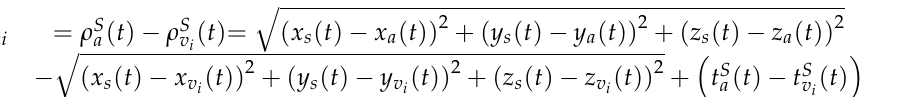
Figure 4. Flowchart of Pseudorange Differencing (PD)-based IVD estimation method. 3.3. Single Differencing Distance The PD estimates the IVD by using the information of the base station; this subsection introduces the single differential method to calculate the IVD only using the pseudorange of vehicles. As shown in Figure 5, the SD method estimates the IVD by using the pseudor- ange of two vehicles from the same satellite. In this way, the clock difference between vehicle receivers can be eliminated, as well as the atmospheric delay error. In general, the atmospheric delay error includes ionospheric delay error and tropospheric delay error. When the GNSS satellite’s signal passes through the atmosphere, the signal will be af- fected by the electron density and water vapor density of the atmosphere. As a result, the signal propagation speed will change as well as the signal propagation time. Using the original signal propagation time to calculate the pseudorange will inevitably cause pseu- dorange errors.